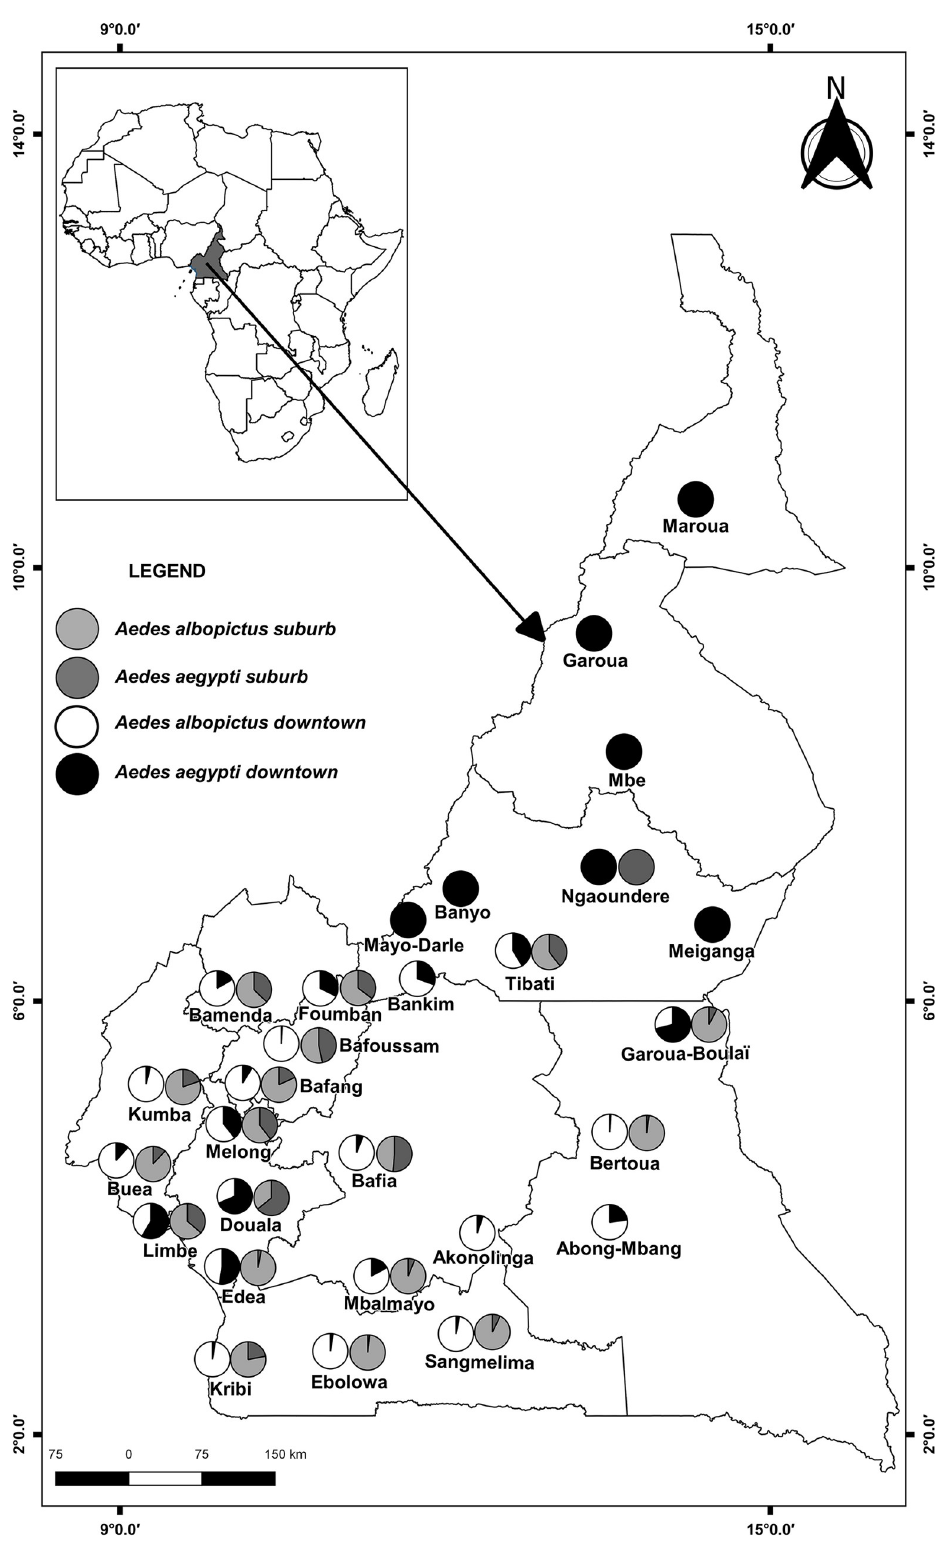
Fig 1. Geographic distribution of Ae . aegypti and Ae . albopictus in Cameroon, March-August 2017.